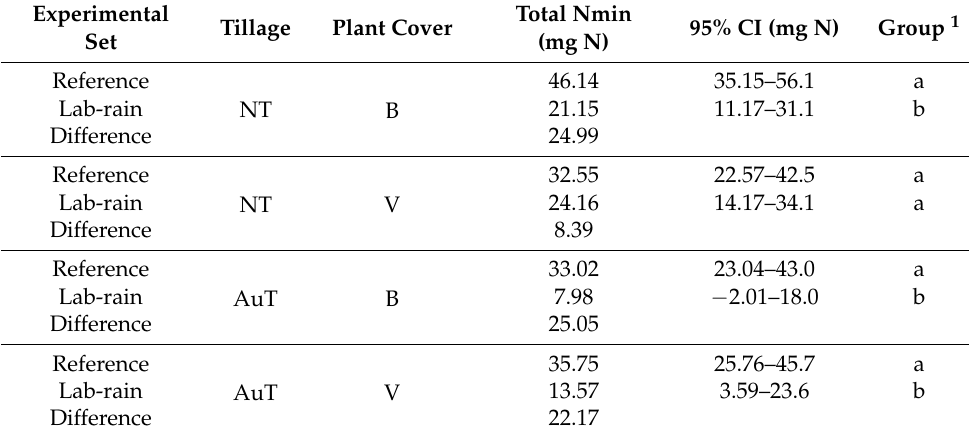
Figure 3. Mineral nitrogen (Nmin) amounts determined in four 5 cm layers in each intact core. Lab-rain cores underwent 200 mm of simulated rain in a laboratory lysimeter before dissection, while Reference cores were dissected without simulated rain. AuT and NT represent, respectively, inversion tillage carried out in late October and no-till. B and V represent bare fallow and winter rye volunteers as cover crops, respectively. The solid lines indicate linear interpolations of Nmin changes with depth. Table 2. Total mineral nitrogen (Nmin) in intact cores dissected after 200 mm of simulated rain in laboratory lysimeters (lab-rain) and without simulated rain (Reference). AuT represents cover crop termination by inversion tillage approximately one month before sampling. NT represents no-till and continued cover crop residence until sampling. B and V represent bare fallow and winter rye volunteers as cover crops, respectively. Model estimates and 95% confidence intervals (CI) for Nmin were obtained from linear mixed effects models with experimental set tillage and plant cover as main effects and experimental block as random